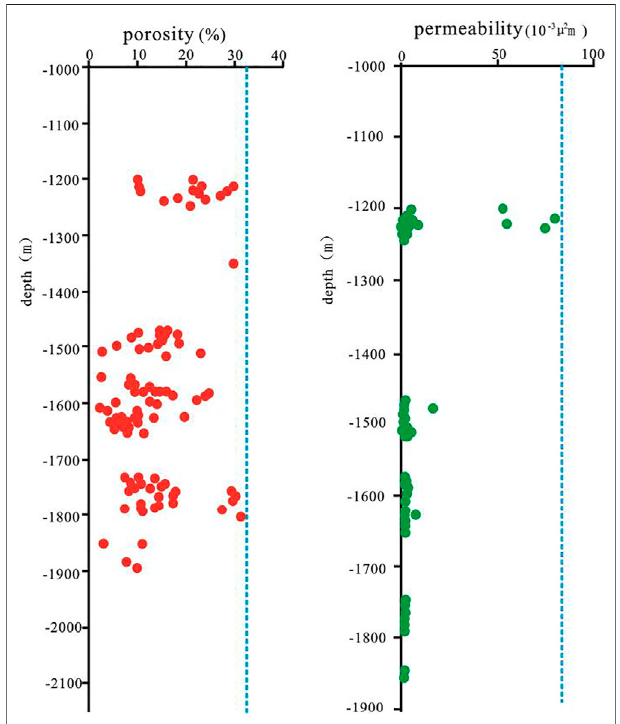
FIGURE 17 | Relationship between porosity, permeability and burial depth of Mesozoic volcanic rocks in D oil fi eld of the Laizhouwan sag.